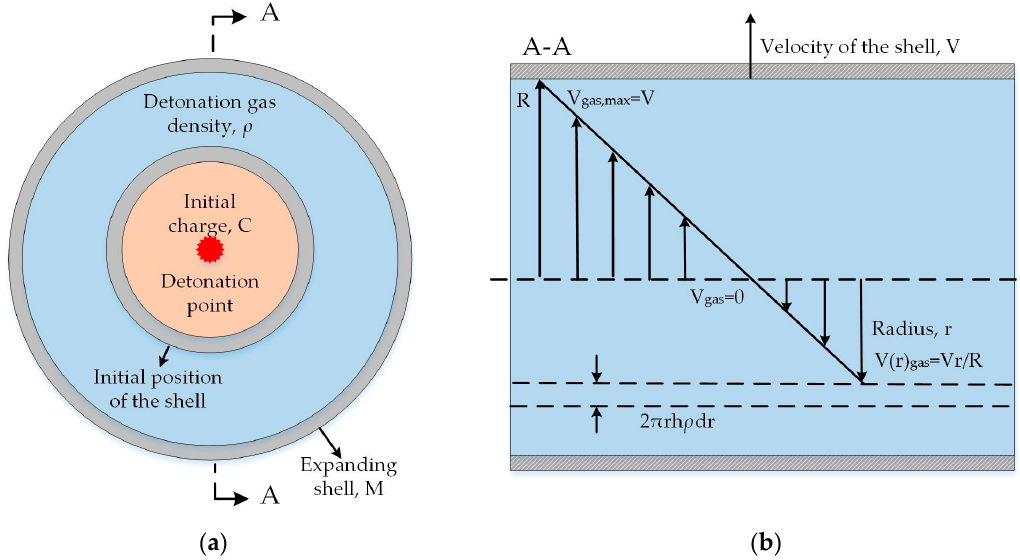
Figure 1. Cylindrical geometry of expanding shell driven by detonation gas: ( a ) vertical view of the shell; ( b ) cross-sectional view of the shell.